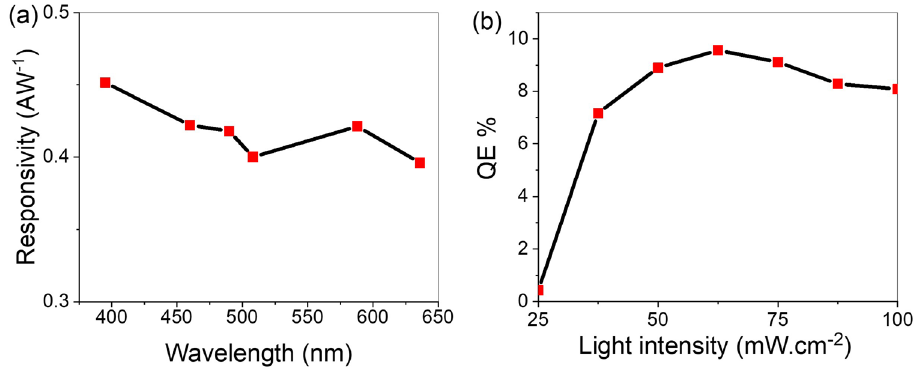
Figure 7. ( a ) The responsivity as a function of wavelengths and ( b ) the EQE under different intensity of light